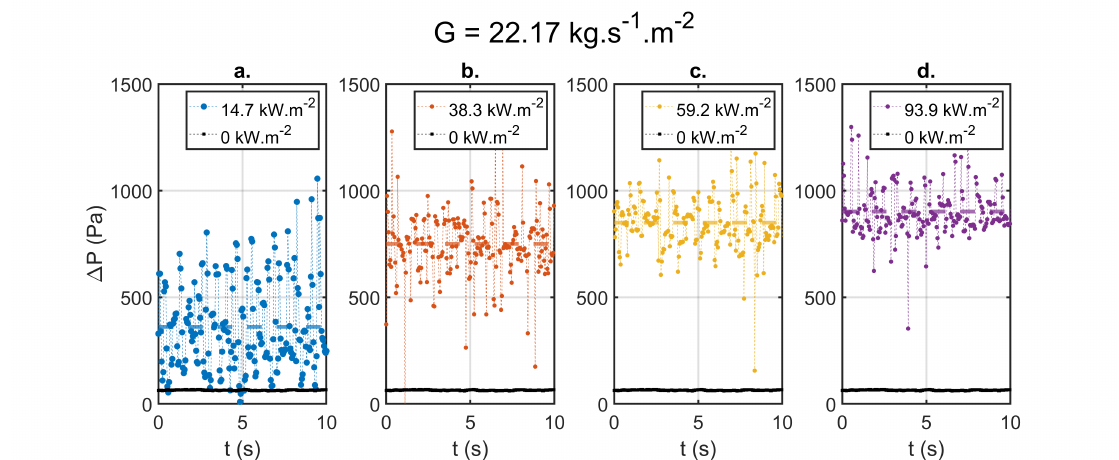
Figure 7. Example of differential pressure drop in different wall heat flux with a constant mass flux of G = 22.17 kg ¨ s ´ 1 ¨ m ´ 2 in channel with D h “ 750 µ m. the black line indicates pressure drop in single phase in room temperature with the same mass flux. ( a ). q 2 “ 14.7 kWm ´ 2 . ( b ). q 2 “ 38.3 kWm ´ 2 . ( c ). q 2 “ 59.2 kWm ´ 2 . ( d ). q 2 “ 93.9 kWm ´ 2